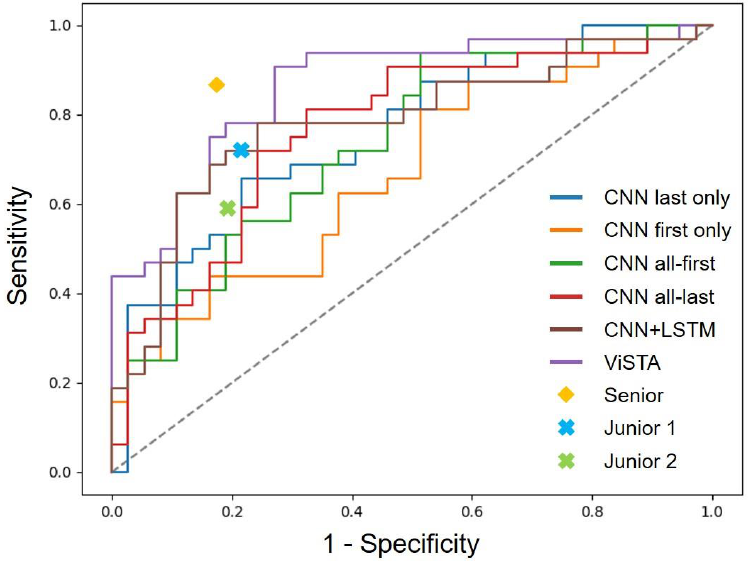
Figure 2. ROC curves of different models compared with performances of radiologists. The gray dotted line indicates the performance of a random classifier with no predictive ability.